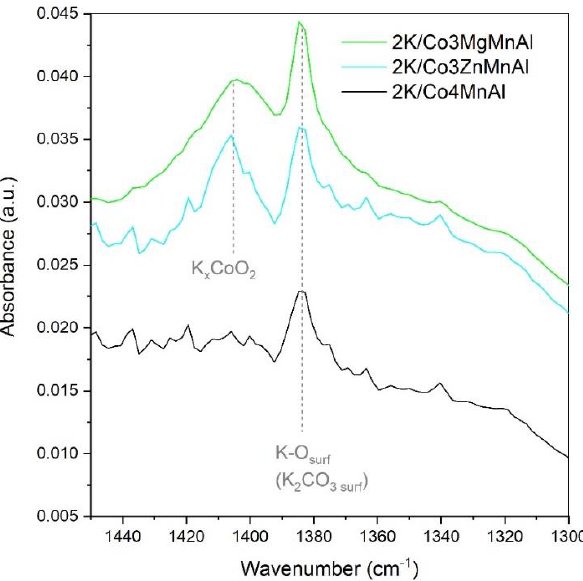
Figure 4. Infrared spectra of prepared mixed oxide catalysts (selected region).